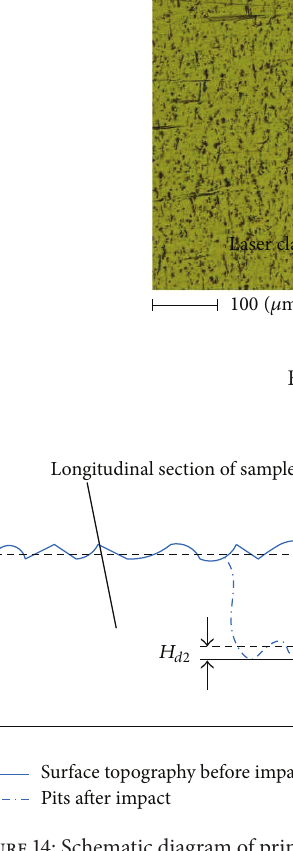
Figure 14: Schematic diagram of principle of measuring the impact